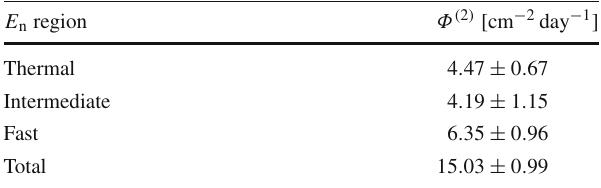
Table7 Neutronfluencerate Φ ( 2 ) derivedfromtheanalysisoftheDS-2 measurement (reactor OFF), normalized per 24h. The uncertainties are stated as standard uncertainties (1 standard deviation). The definition of the E n regions is identical to Table 6